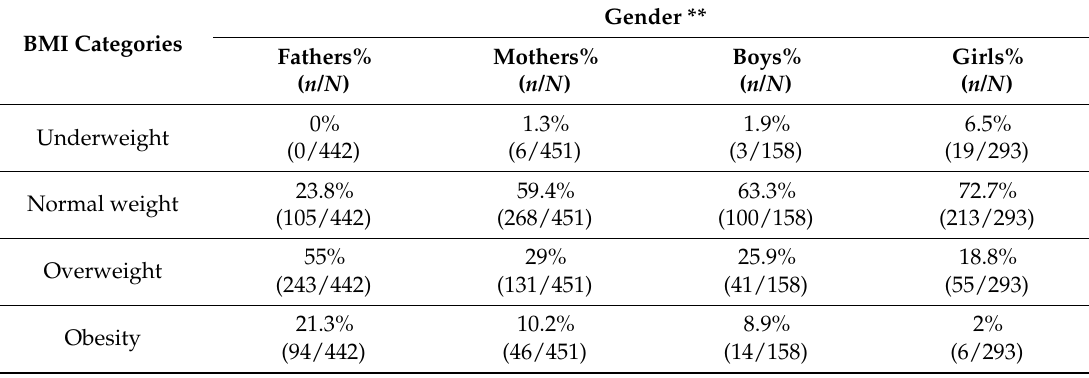
Table 2. BMI categories of parents and